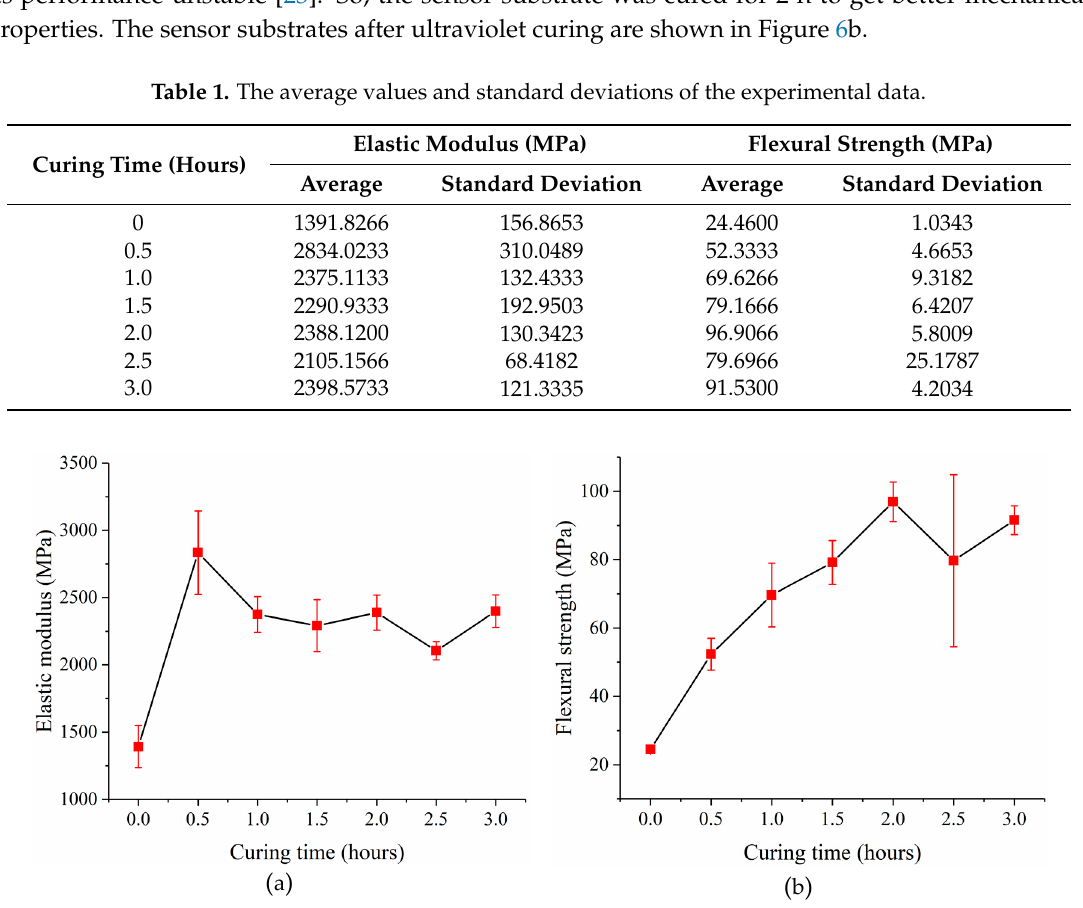
Figure 7. ( a ) The elastic modulus of the post-cured resin versus curing time; ( b ) the flexural strength of the post-cured resin versus curing time.